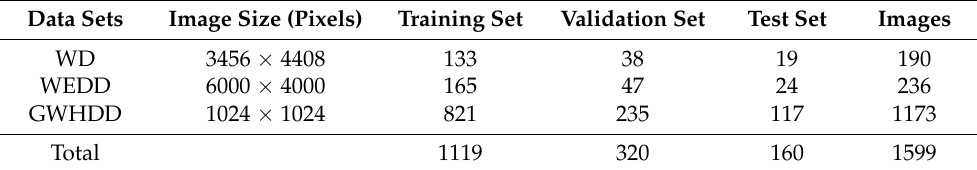
Table 1. Related datasets.